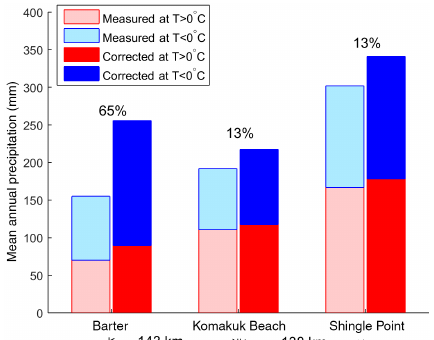
Figure 7. Mean annual (1978–1988) measured and corrected pre- cipitation for cold ( T <0 ◦ C) and warm ( T >0 ◦ C) months. The per- centages are the changes from measured to corrected precipitation. The approximate horizontal distance between the stations is dis- played at the